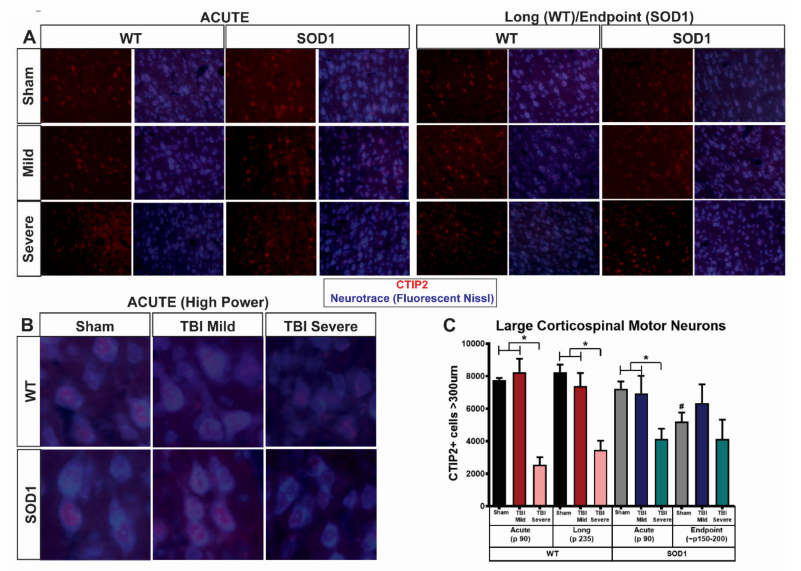
Figure 5. SOD1 rats with acute severe symptoms following repeat TBI display an early loss of corticospinal motor neurons. Immunostaining for CTIP2 and Neurotrace at ( A ) low and ( B ) high magnification showed a significant reduction and apparent disorganization of large CTIP2+ (COUP-TF-interacting protein 2) cells located in layer V of the motor cortex occurring in both WT and SOD1 TBI “severe” rats. Quantitative stereological analysis ( C ) revealed that this reduction occurred in the acute phase in only rats (both WT and SOD1) that exhibited early severe functional deficits and not those TBI rats that presented with mild phenotypic symptoms (* p < 0.05, error bars signify standard error of the mean, SEM). As expected, SOD1 sham endpoint animals exhibited a disease-related reduction in large CTIP2+ cells (>300 µ m) relative to earlier timepoints ( p < 0 .05) and this was not exacerbated with injury. Importantly, however, SOD1 rats experiencing early severe symptoms following repeat TBI showed an early reduction in large CTIP2+ cells at the acute time point not observed in SOD1 sham or mild rats at this